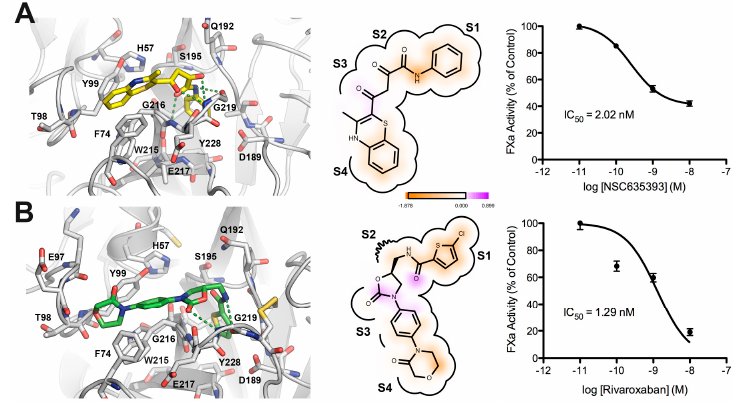
Figure 7. Comparison between the predicted binding mode and in vitro FXa inhibition for ( A ) compound 5 (NSC635393) and ( B ) Rivaroxaban.